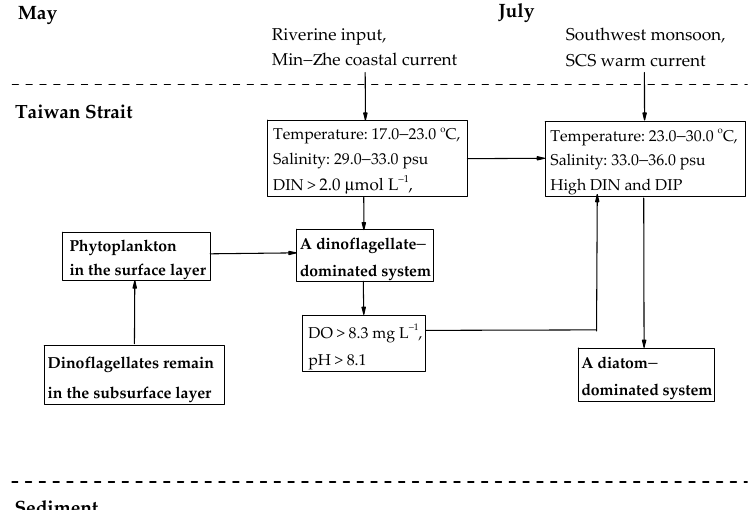
Figure 6. A conceptual model for the combined effects of environmental drivers on phytoplankton community composition during May to July in the Taiwan Strait. SCS: South China Sea, DO measured dissolved oxygen concentration, DIN: dissolved inorganic nitrogen concentration, DIP: dissolved inorganic phosphorus concentration.